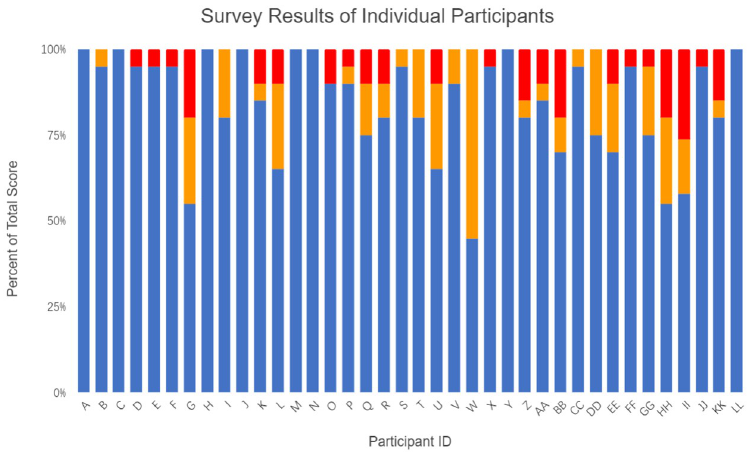
Fig 7. Individual survey response scores (n = 38). Bar chart illustrating total score (Blue), false negative (Red), and false positive (Orange) when assessing images.